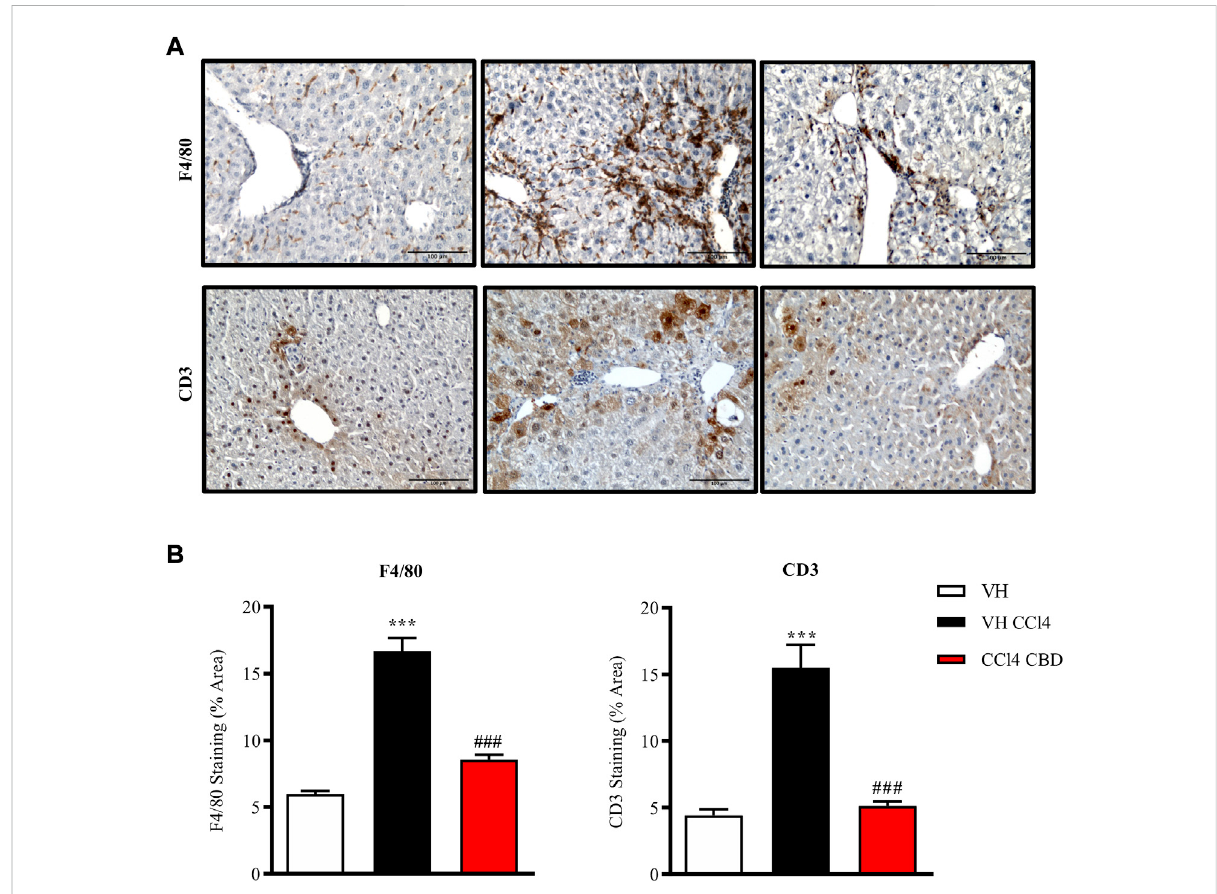
CBD reduces hepatic in fl ammation induced by CCl4. (A) Representative images of immunostaining for F4/80 (macrophage-speci fi c marker; upperpanel)and CD3(lymphocyte-speci fi cmarker; bottom panel)fromcontrol,CCl4-vehicle,andCCl4+ CBDmice. Scalebarsrepresent 100 μ